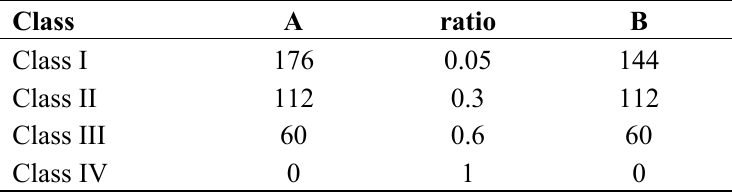
Table 3. The parameter values at a temperature of 25